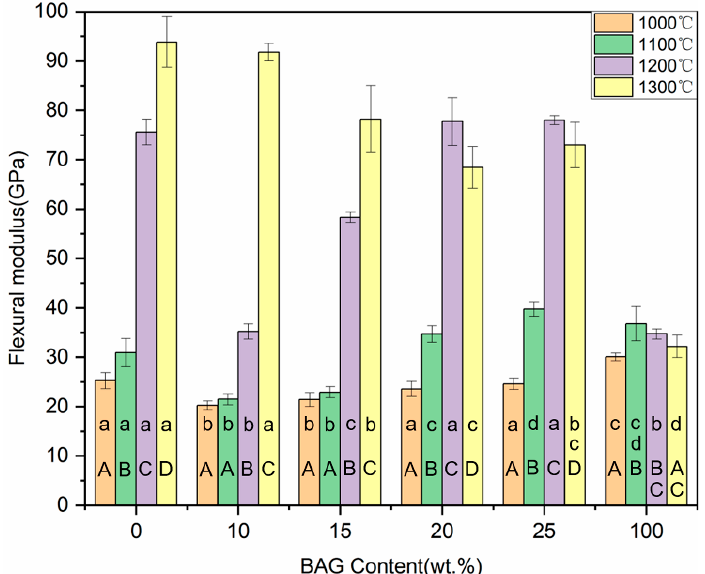
Figure 11. Flexural strength of specimens with different sintering temperatures and different BAG contents. a the same lowercase letters indicate that there was no significant difference between different BAG contents at the same sintering temperature ( p = 0.05). A the same uppercase letters indicate that there was no significant difference between different sintering temperatures with the same BAG content ( p = 0.05). The data were significantly drawn from a normally distributed population at the 0.05 level.